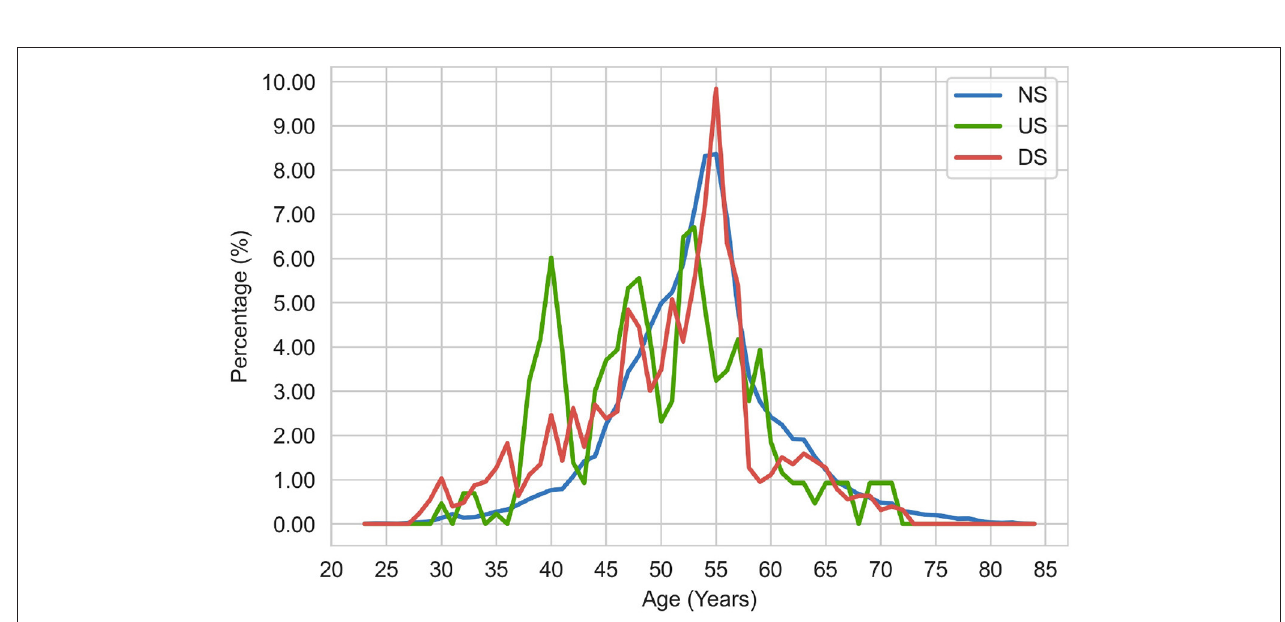
FIGURE 3 | Distribution of chairperson education across different company performance statuses.